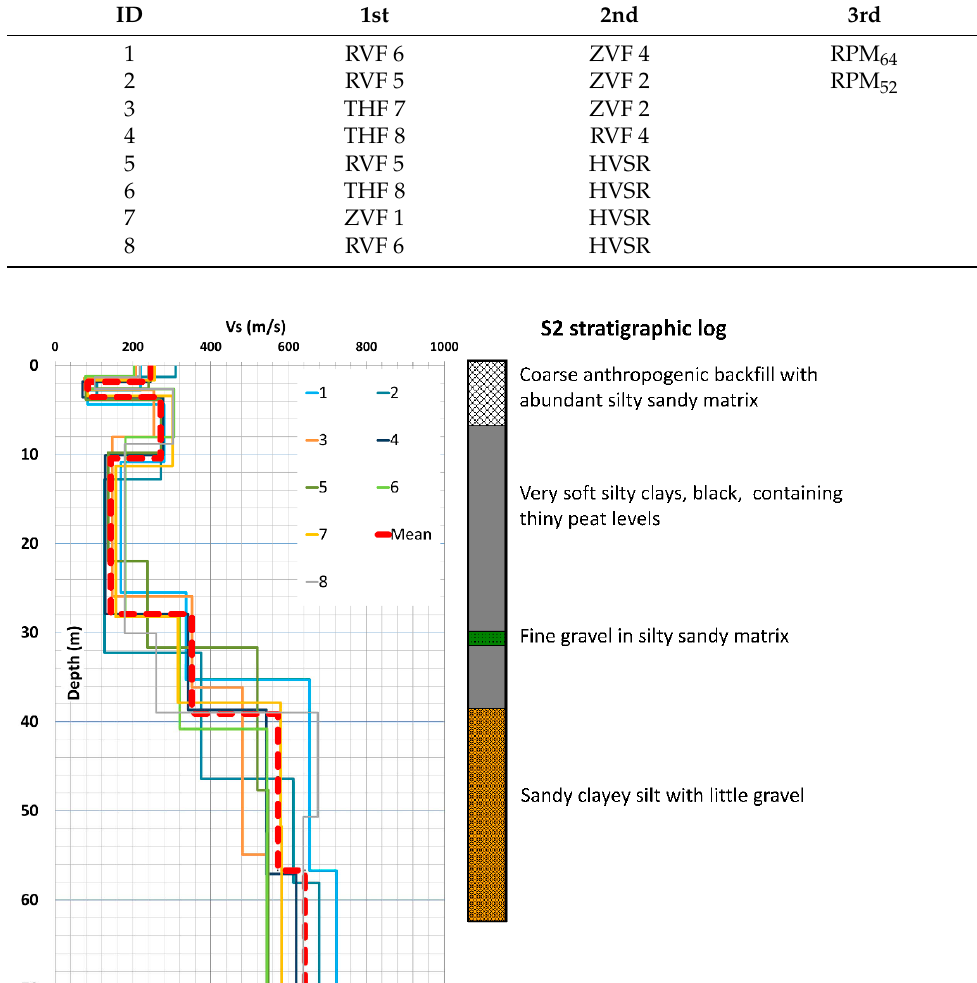
Table 3. Data used during joint inversion step (refer to Table 1 for abbreviations).